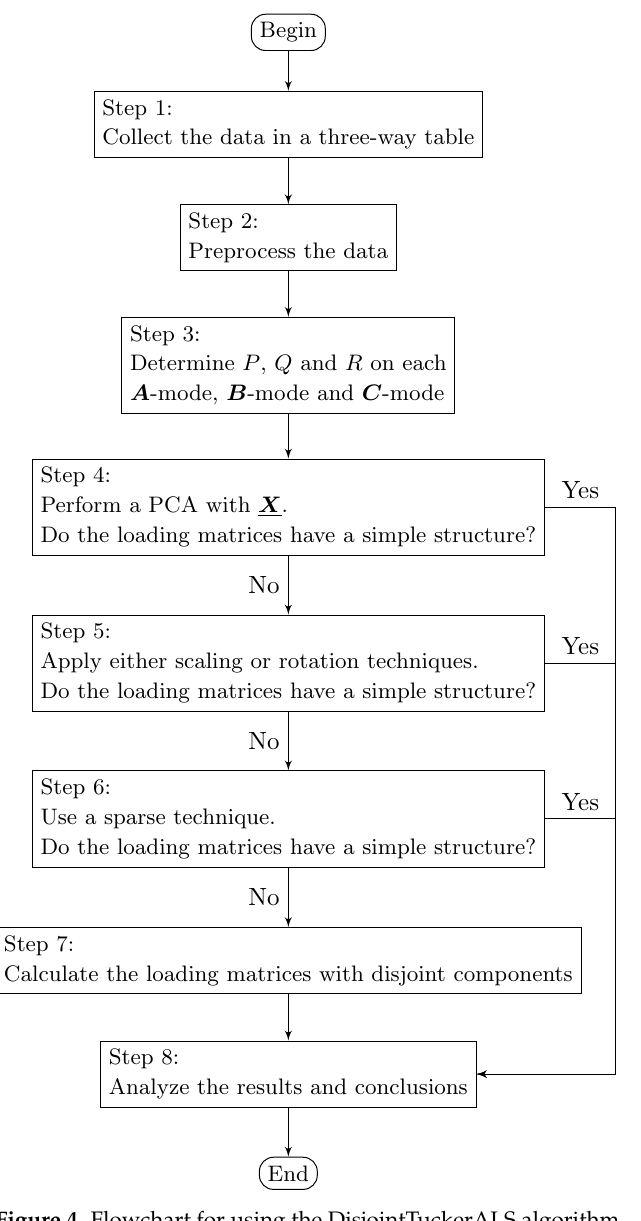
Figure 4. Flowchart for using the DisjointTuckerALS